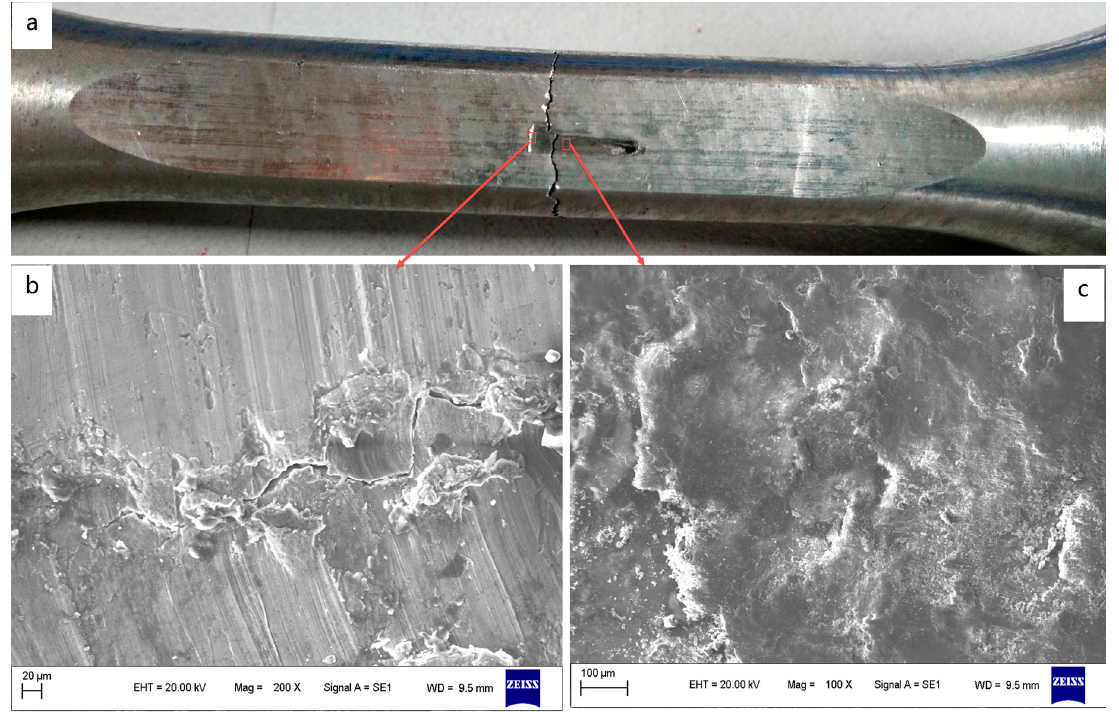
Figure 7. Fretting scar of fretting fatigue specimen. ( a ) Fretting scar and fracture position; ( b ) Morphology of scar, near the edge of fretting region; ( c ) Morphology of scar, far away from the edge of fretting region.